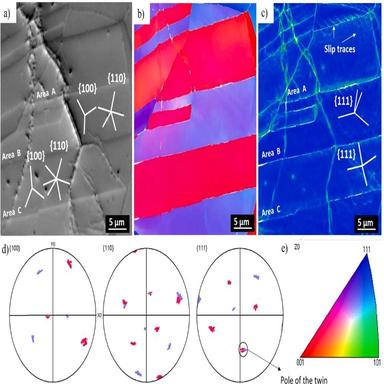
EBSD analysis of Pb-caustic SCC cracks. (a) SE image of a crack displaying crystallographic morphology, (b) IPFZ map and (c) local misorientation map. (d) Pole figures extracted from Area B and C with the (e) colour legend associated with the map in (c). The traces of , and planes are displayed in (a) and (c).